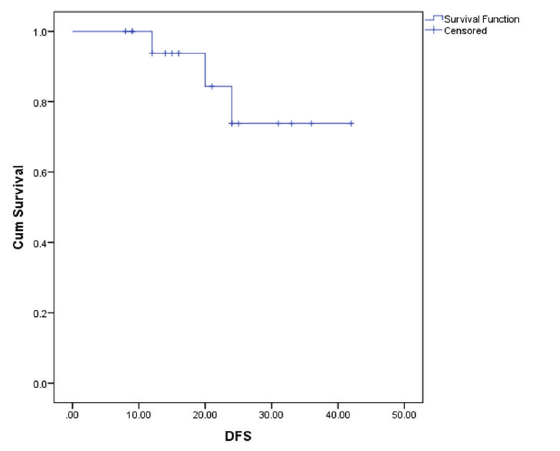
Figure 1: Kaplan-Meier survival curve of disease-free survival